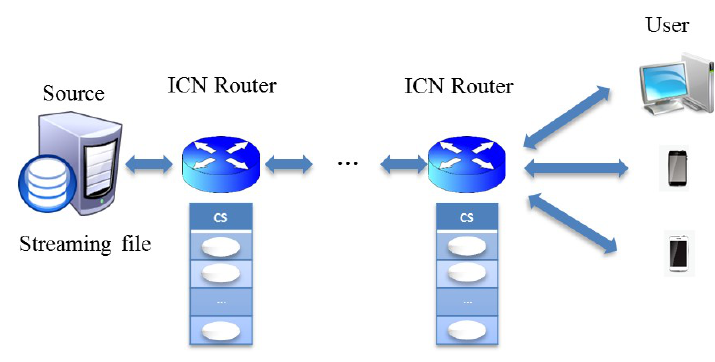
Figure 2. In-network caching for a streaming content delivery scenario. ICN: Information-Centric Networking; CS: Cache